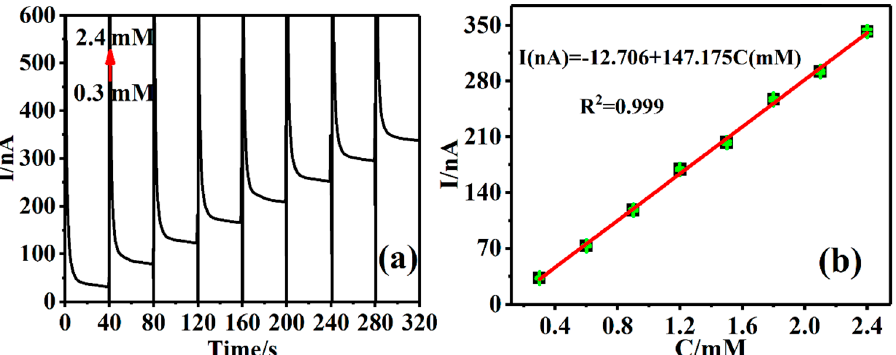
Figure 7. ( a ) Amperometric I-t response at Cu-TCPP@MOFs/GCE in 0.1 M PBS (pH = 7) applied potential of 0.1 V; ( b ) The standard curves of the peak currents versus different concentrations of AA solution.